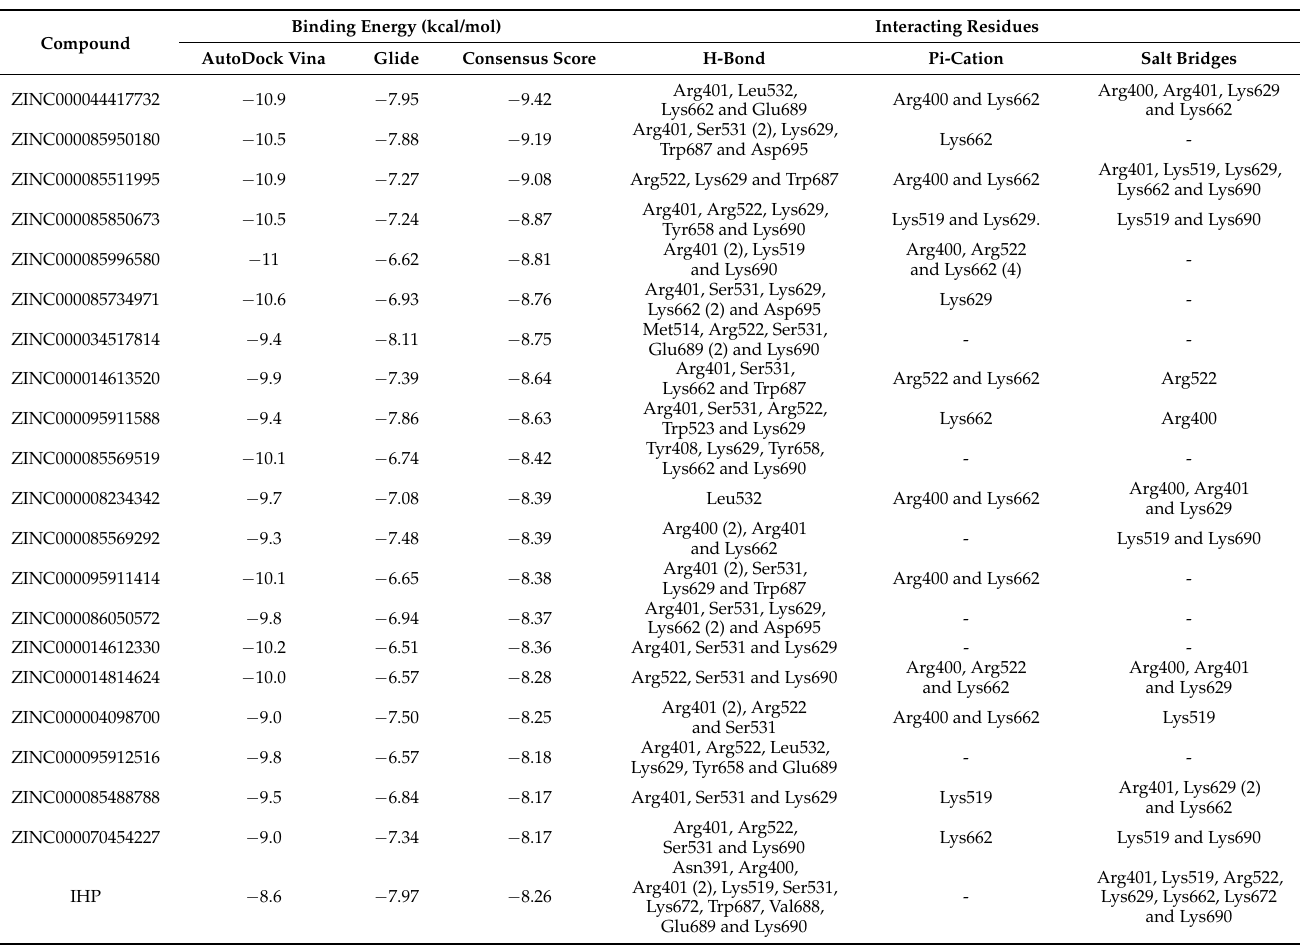
Table 2. Binding energies of IHP and some selected compounds with ADAR2. The interacting residues are also shown. The glide docking and consensus scores presented here are rounded to 2 decimal